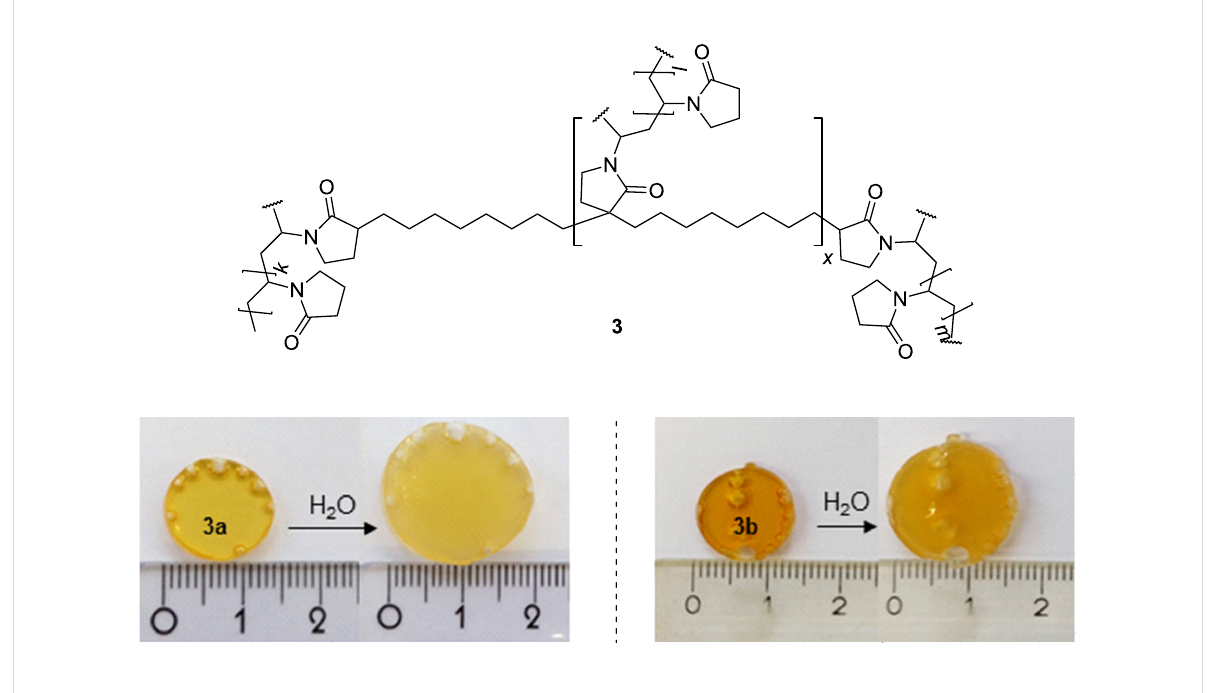
Figure 1: Chemical structure of water swellable network 3a and 3b . Photographs of water-swollen polymer disks consisting of 1 mol % ( 3a ) and 2.5 mol % ( 3b ) of 2a as cross linker.